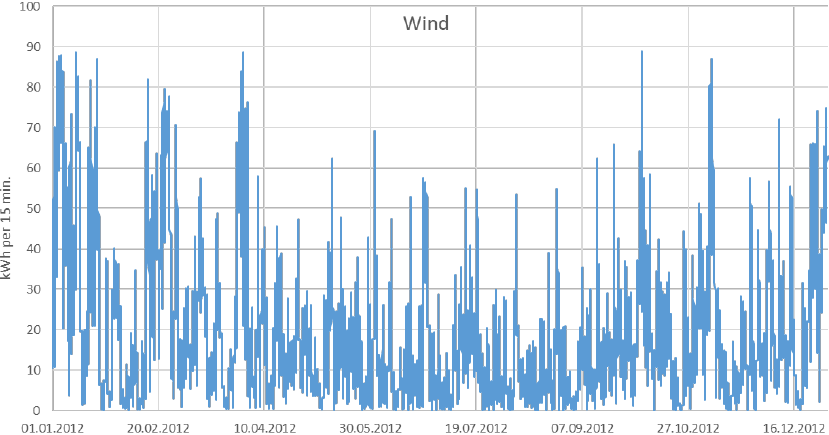
Figure 4. Daily electricity production from a wind turbine, scaled down to 215 kWp, measured based on 15 min values from Neustrelitz wind park, Germany, 2012; annual output approximately 645,000 kWh.